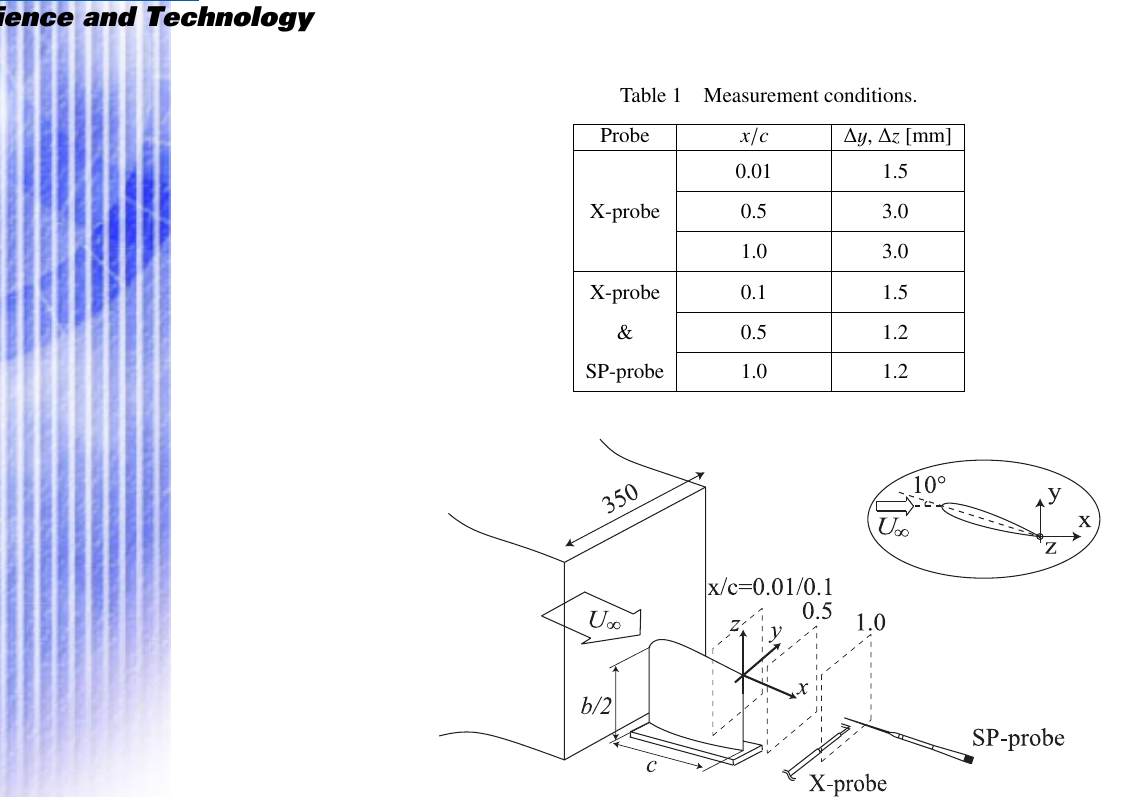
Fig. 1 Schematic of the experimental configurations in probe position 2 (see Fig. 2).